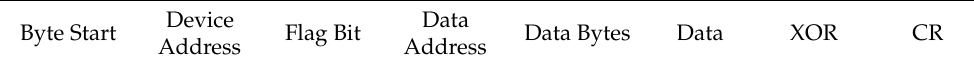
Table 4. Data reading command received by the upper computer.